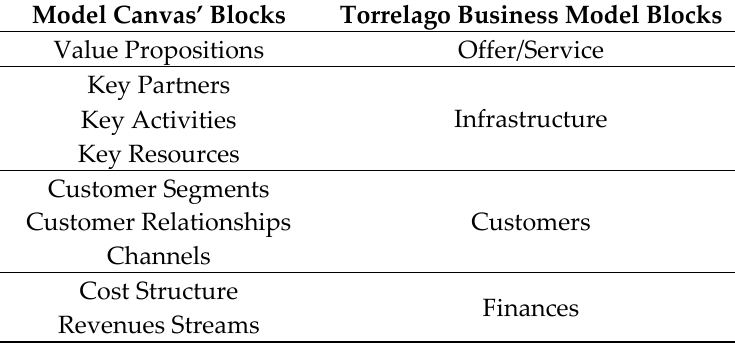
Table 1. Business case blocks.